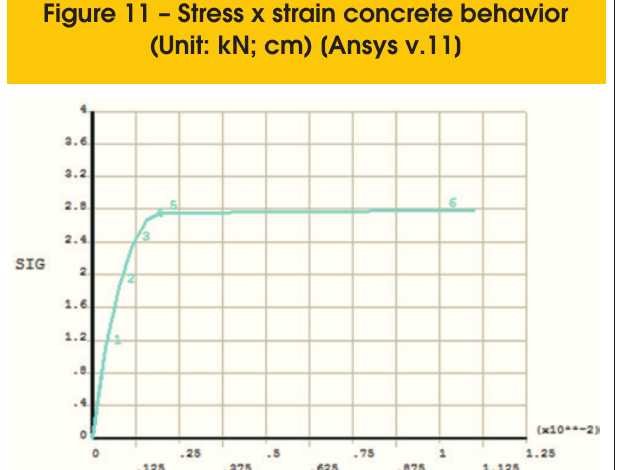
Figure 12 –Stress x strain steel behavior (Unit: kN; cm) [Ansys